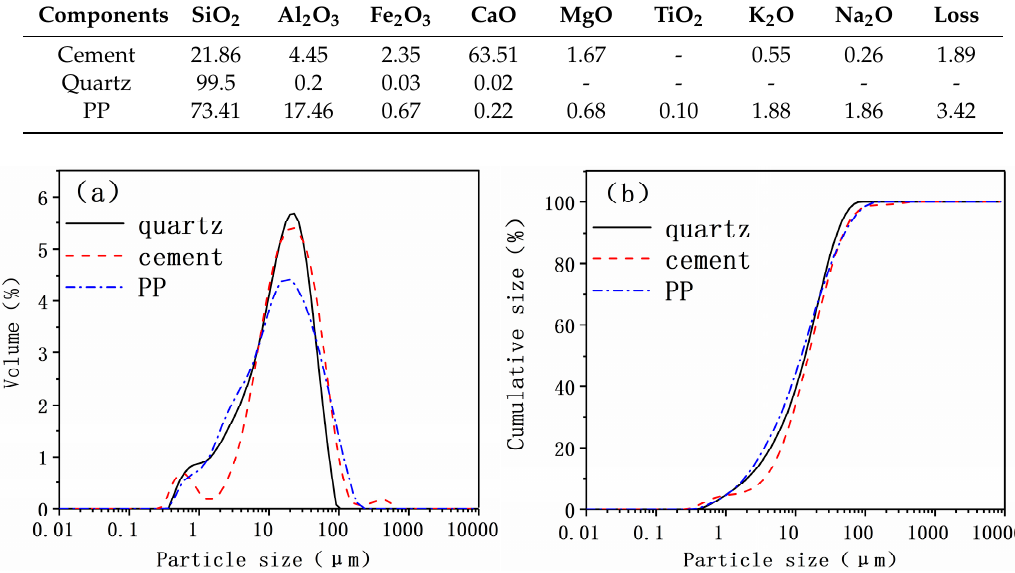
Table 1. Chemical composition (%) of cement, quartz, and polishing powder.